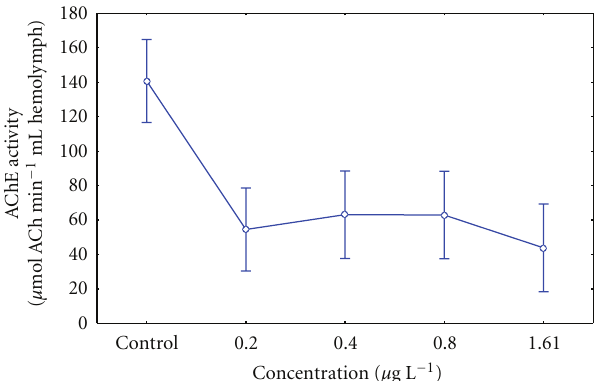
Figure 1: AChE activity in Aulacomya ater exposed to grow sublethal concentrations of organophosphate pesticide Lorsban 4E for 21 days. Mean values with standard error plotted ( ∗ statistical di ff erence P < 0 . 05).